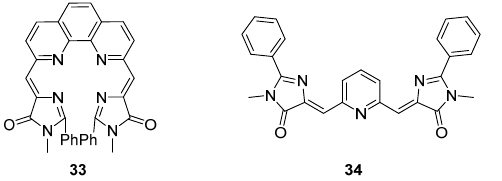
Figure 31. GFPc analogues for the detection of metallic cations [13,49].